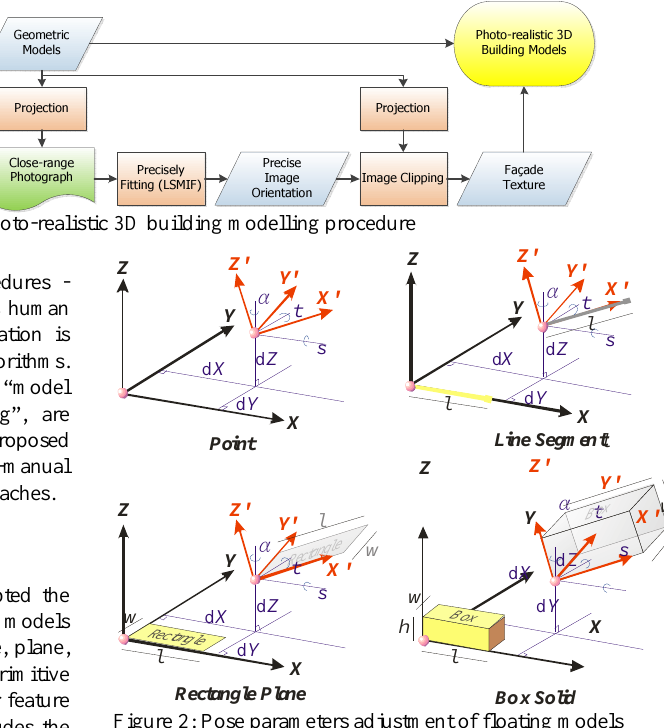
Figure 2: Pose parameters adjustment of floating models